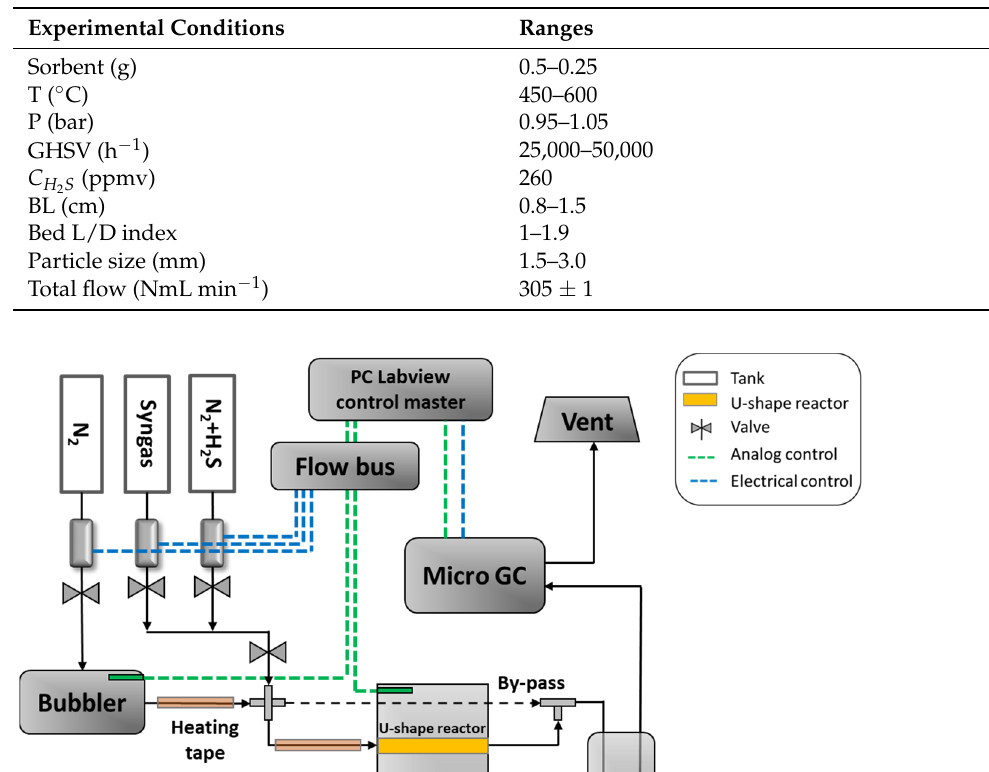
Table 3. Sorbent experimental setup using syngas.